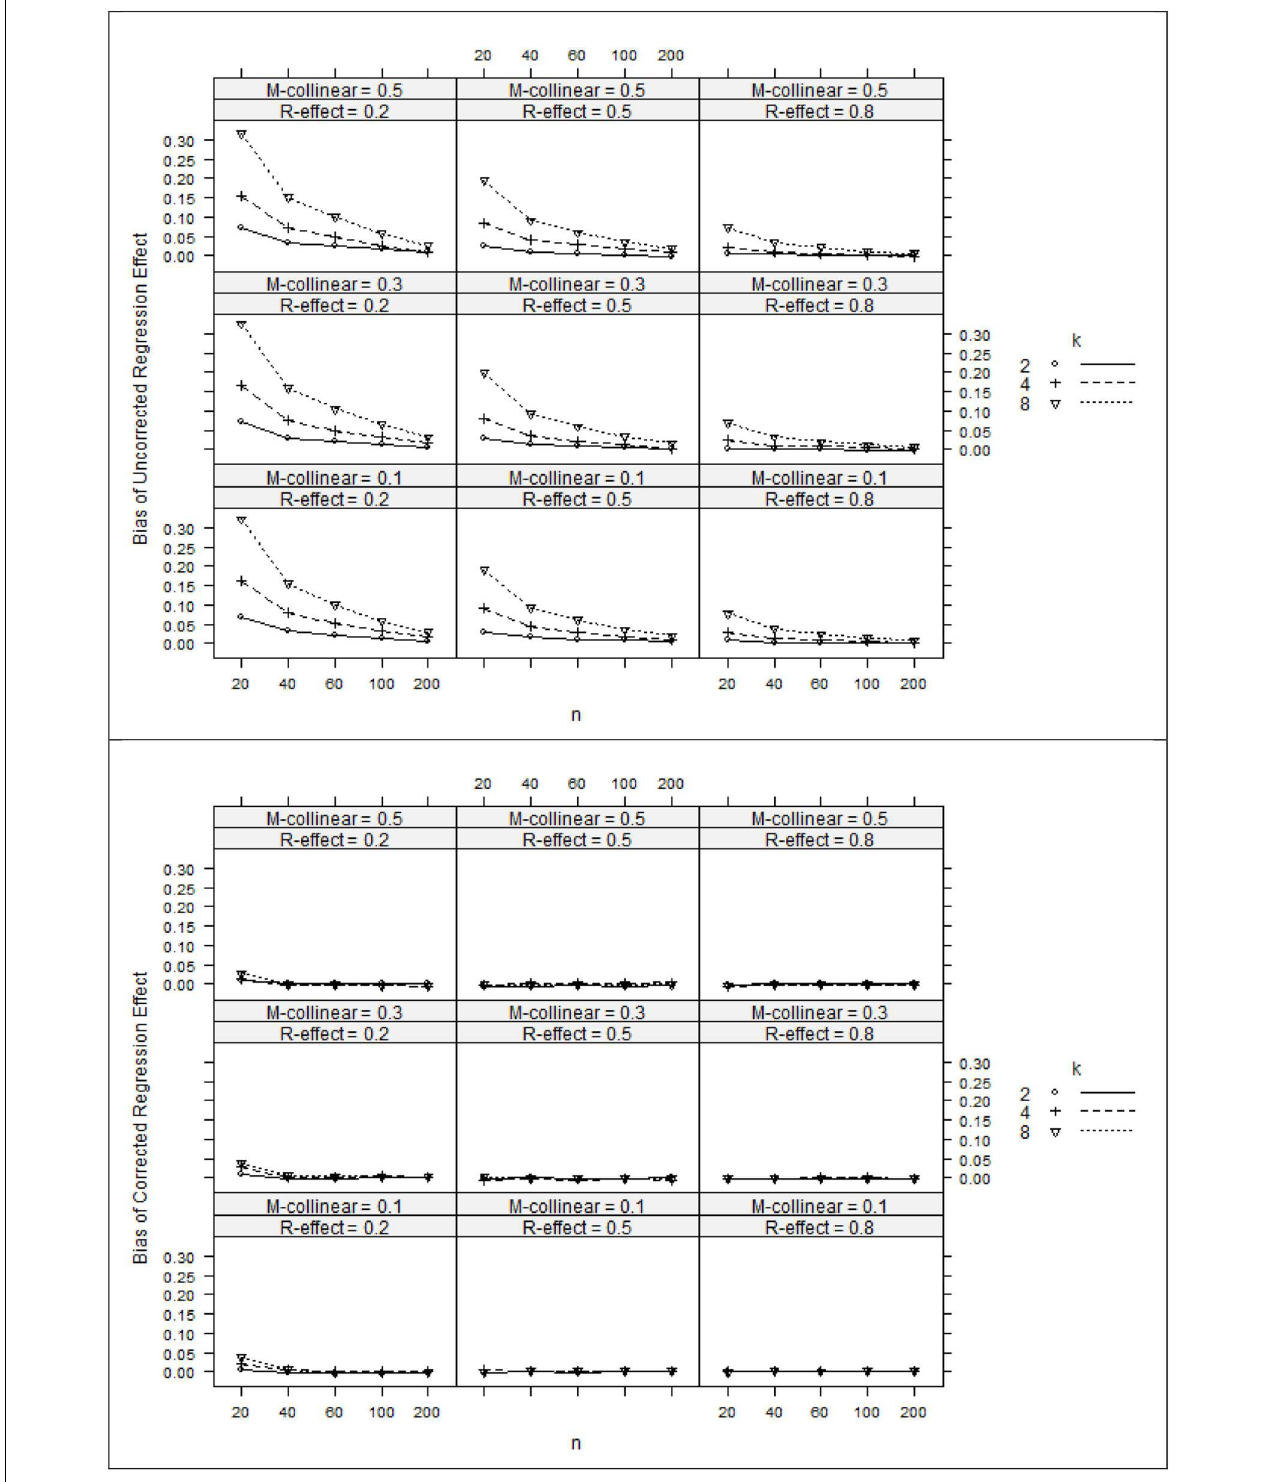
FIGURE 2 | Bias of regression effects (top panel) and corrected regression effects (bottom panel). k , number of predictors; n , sample size.